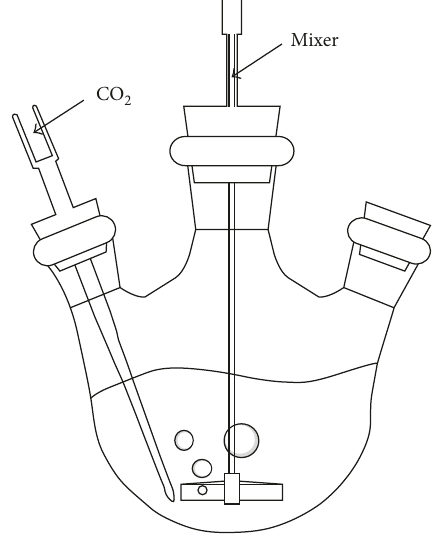
Figure 2: Ca(OH) 2 -H 2 O-CO 2 reaction